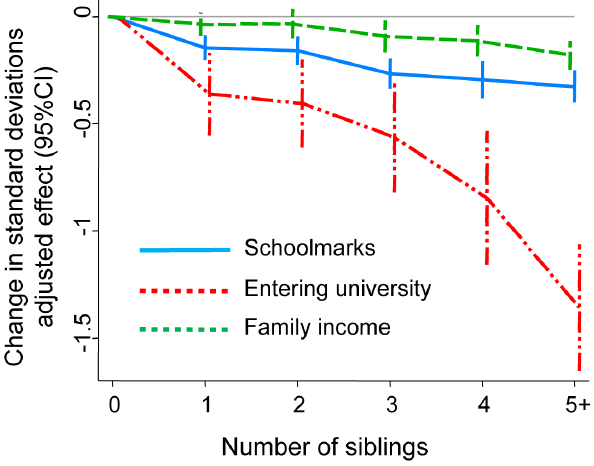
Figure 1. Association of the cohort members’ total family size with their schoolmarks educational attainment and adult income. Analyses based on the 10,939 individuals with valid data on sibling sex. Adjusted effects show the difference in standard deviations relative to zero siblings, based on multivariable models adjusting for the early-life characteristics shown in Table 1.